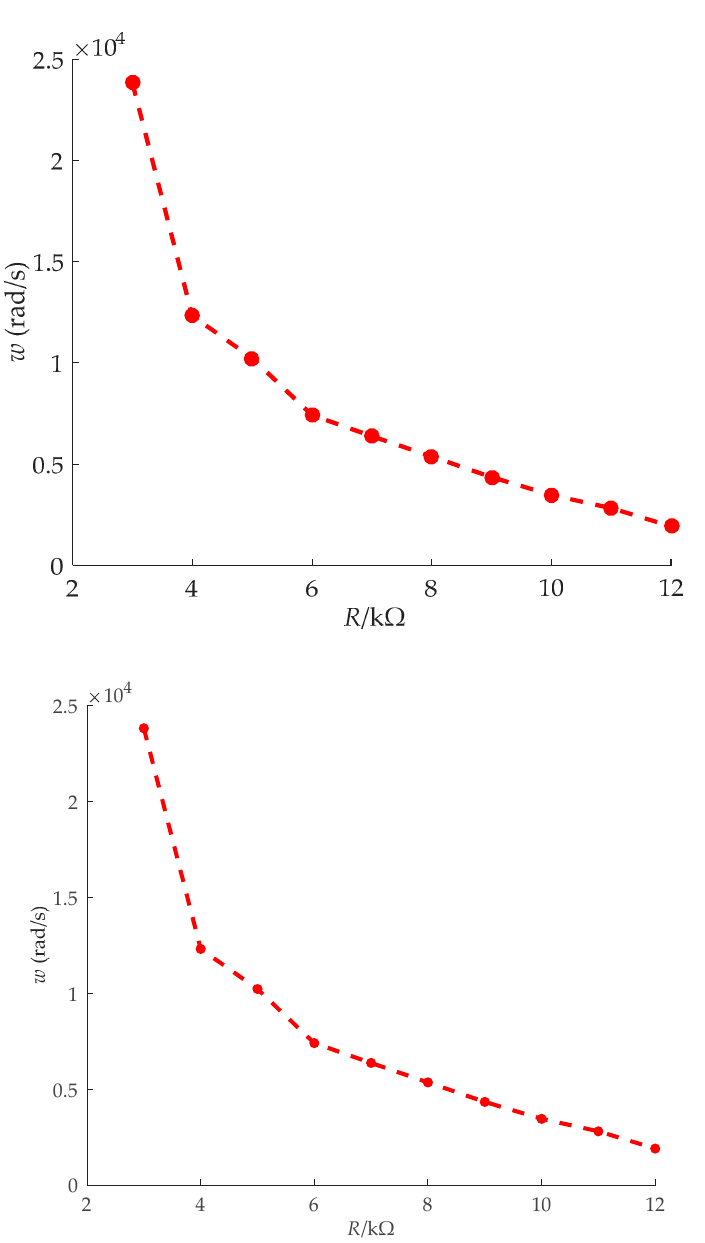
Figure 12. Relationship between resistor divider and frequency measurement range.